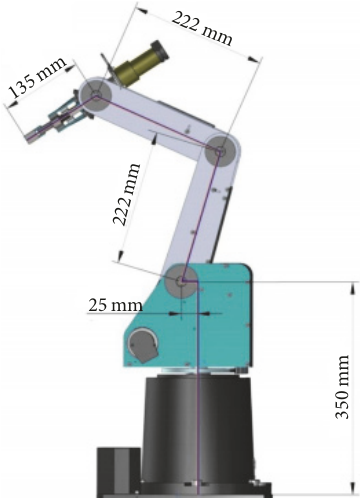
Figure 2: Mechanical structure of the Scorbot manipulator [7].